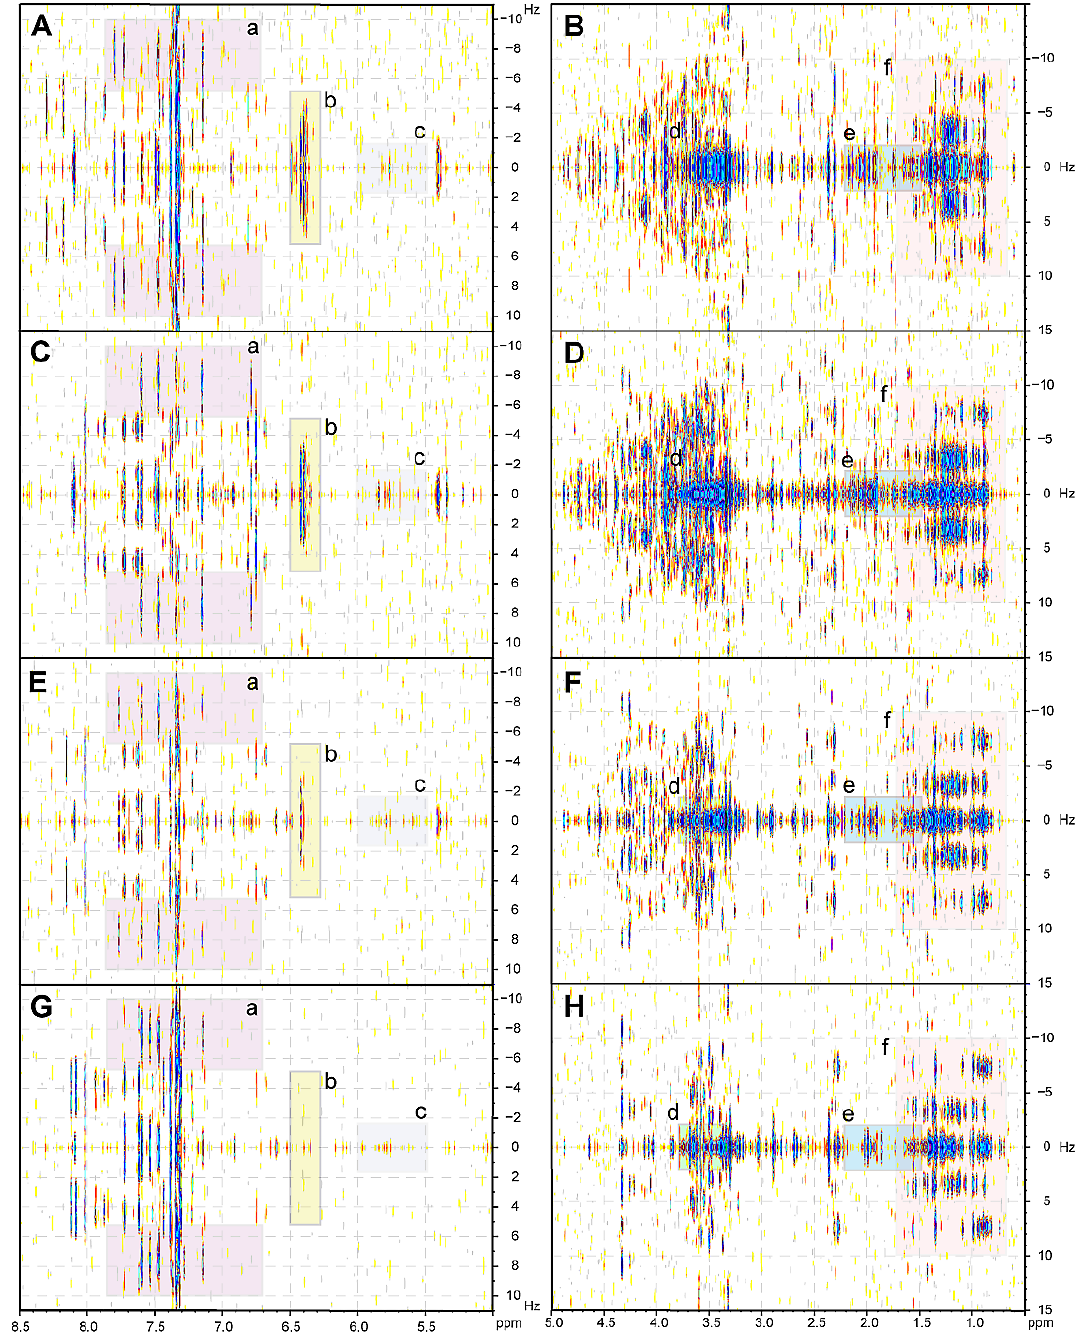
Fig. 5. 1 H, 1 HJRESNMR spectra of (A, C, E, G) downfield ( δ H = 5.0–8.5ppm; aromatic and olefinic C-C sp2 H -C sp2 H -C cross peaks) and (B, D, F, H) upfield 1 HNMR chemical shift region ( δ H = 0.5–5.0ppm; aliphatic C- HC - HC -X (X: C, N, O)) cross peaks of marine SPE- DOM. (A, B) 5m (near-surface photic zone); (C, D) 48m (fluorescence maximum); (E, F) 200m (upper mesopelagic zone); (G, H) 5446m (30m above seafloor). (a) α , β -unsaturated carbonyl compounds with n J HH > 12Hz; (b) olefinic protons with small (remote) couplings of n J HH ≤ 3Hz, indicative of natural products; (c) isolated olefinic protons with small couplings of n J HH < 1Hz, possibly at quaternary bridgehead carbon; (d) methoxy groups, which only exhibit long-range couplings n J HH ( n = 4 for methyl ethers and n = 5 for methyl esters; cf. Fig. 8c); (e) methyl protons: acetate derivatives ( δ H > 1.9ppm) and aliphatic methyl ( δ H < 1.6ppm); (f) methyl bound to methine (doublet, 3 J 3 J HH ∼ 7 Hz) and methylene (triplett, HH ∼ 7